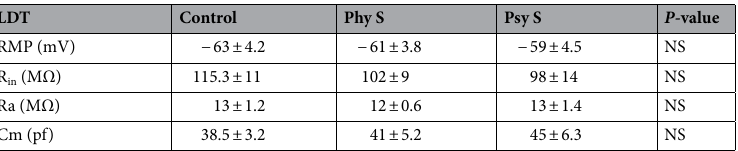
Table 1. Passive properties of laterodorsal tegmentum cell membranes. RMP (mV): Resting membrane potential (mV), R